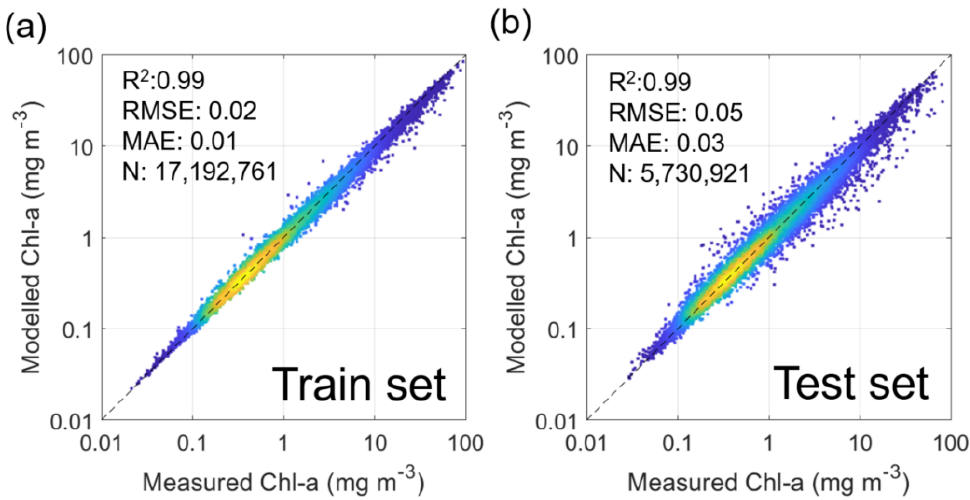
Figure 1. Scatter plots showing relationships between satellite measured Chl-a and modeled Chl-a for ( a ) training and ( b ) test sets.